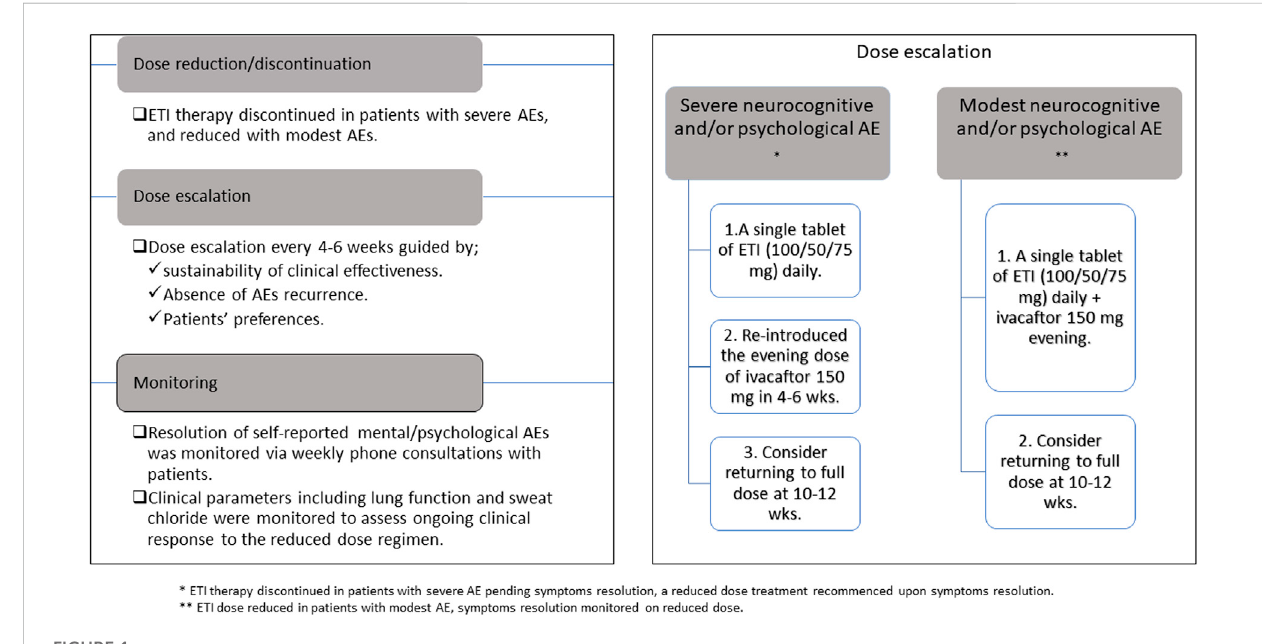
FIGURE 1 Outline of elexacaftor/tezacaftor/ivacaftor dose reduction